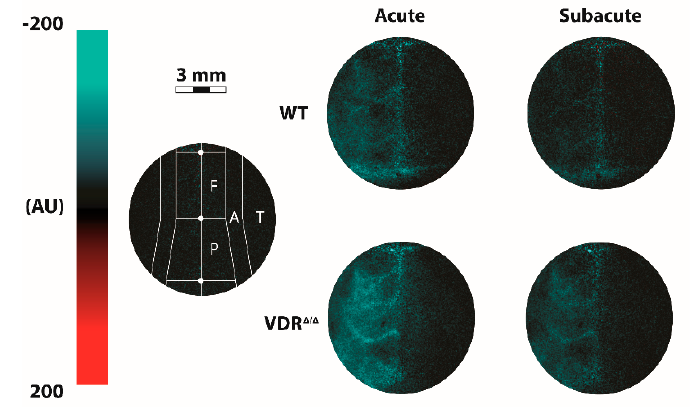
Figure 1. Localization of the regions of interest for cerebrocortical blood flow (CoBF) measurements and the CoBF reductions in the acute and subacute phase of adaptation after left carotid artery occlusion (CAO). The decrease in CoBF ipsilateral to CAO was more pronounced in the vitamin D receptor (VDR ∆ / ∆ ) mice as compared to wild-type (WT) animals with the most sustained reductions in the temporal cortex (indicated by blue color). The first 30 s after CAO was considered as the acute phase, and the following 270 s was the subacute phase of adaptation. AU: arbitrary units, F: frontal cortex, P: parietal cortex, A: zone of pial anastomoses, T: temporal cortex. At the end of each experiment, the femoral artery cannula was used for arterial blood sampling to determine arterial blood gas tensions, acid / base parameters, and plasma ion concentrations (Ca 2